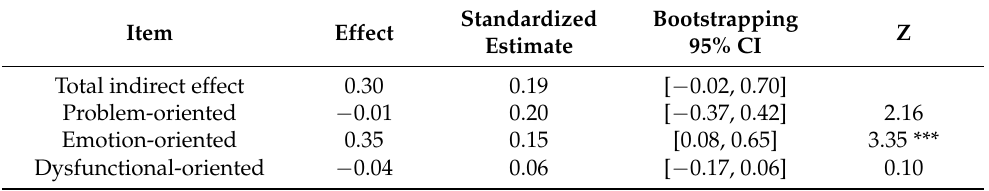
Table 4. Testing the mediating effect of coping strategies for perceived stress on post-traumatic growth. Item